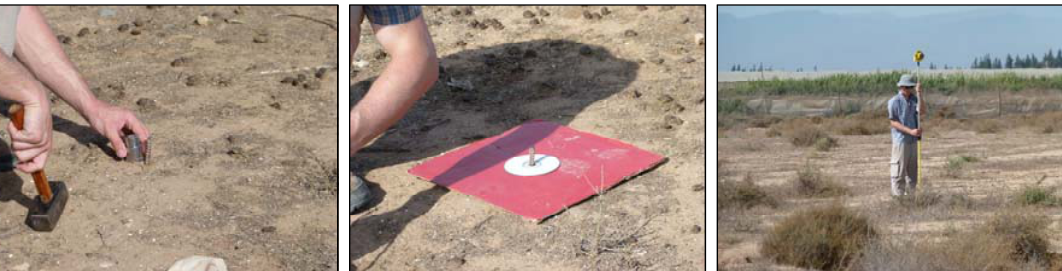
Figure 4. Ground control point (GCP) installation workflow (Photo: W. d’Oleire-Oltmanns 2011).